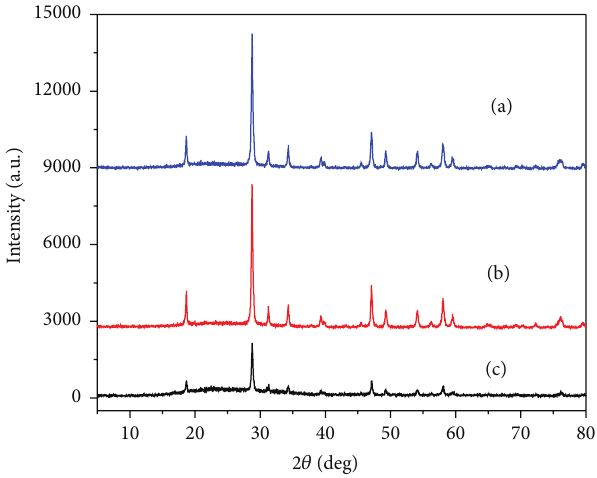
Figure 1: XRD patterns of the as-prepared CaWO 4 samples synthe- sized by microwave-assisted method at 120 ∘ C for different reaction times: (a) 15min, (b) 10min, and (c) 5min, respectively.